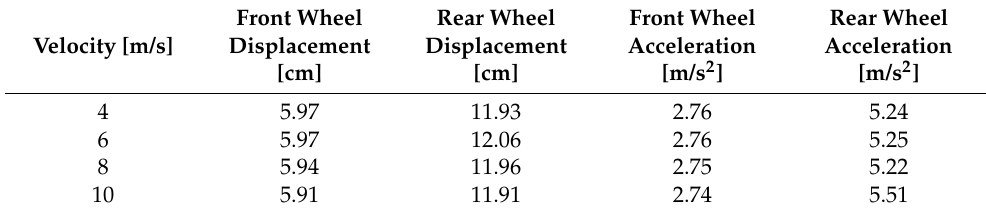
Table 5. Maximum net displacement and acceleration of front and rear wheels at different speeds.